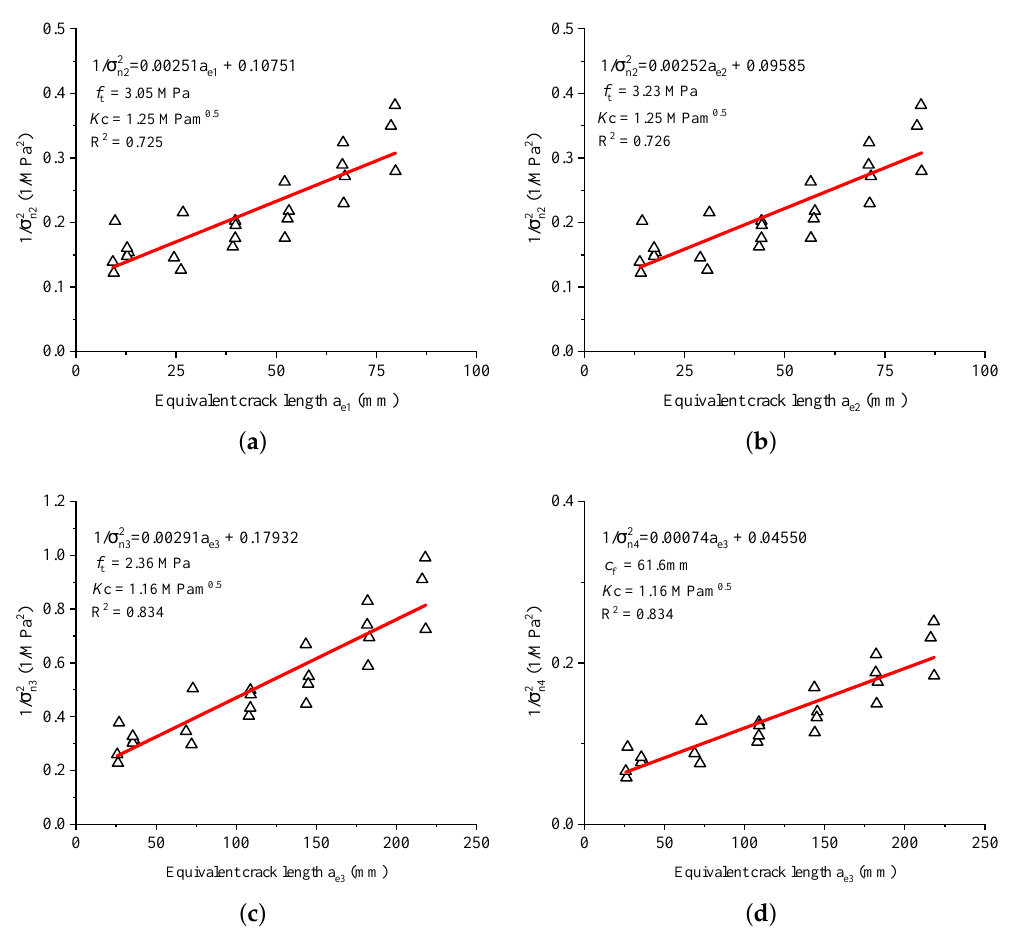
Figure 5. Test results in [28,29] and the corresponding fitted curves of ( a ) Hu-Guan’s boundary effect model with β 1 = 1, ( b ) modified Hu-Guan’s boundary effect model with β 1 = 1, ( c ) Koval-Gao’s size and boundary effect model and ( d ) Bažant’s Type 2 size effect